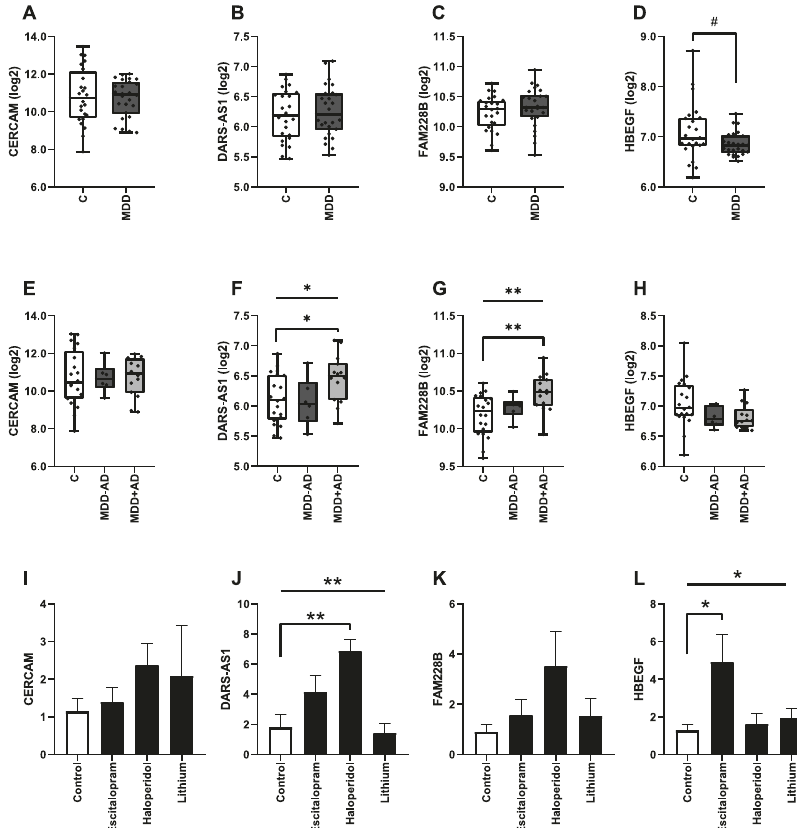
Fig. 3 Expression in the brain and in vitro. Gene expression in the anterior cingulate cortex of controls C , individuals with major depressive disorder (MDD), depressed individuals not taking antidepressants (MDD − AD), and depressed individuals taking antidepressants (MDD + AD) was quanti fi ed by RNA sequencing, for CERCAM A , E , DARS-AS1 B , F , FAM228B C , G , and HBEGF D , H . The effects of drug treatment on gene expression in neural progenitor cells was assessed after 48 h of treatment, for CERCAM I , DARS-AS1 J , FAM228B K , and HBEGF L . For cell experiments, expression values were normalized to B-actin, and error bars represent